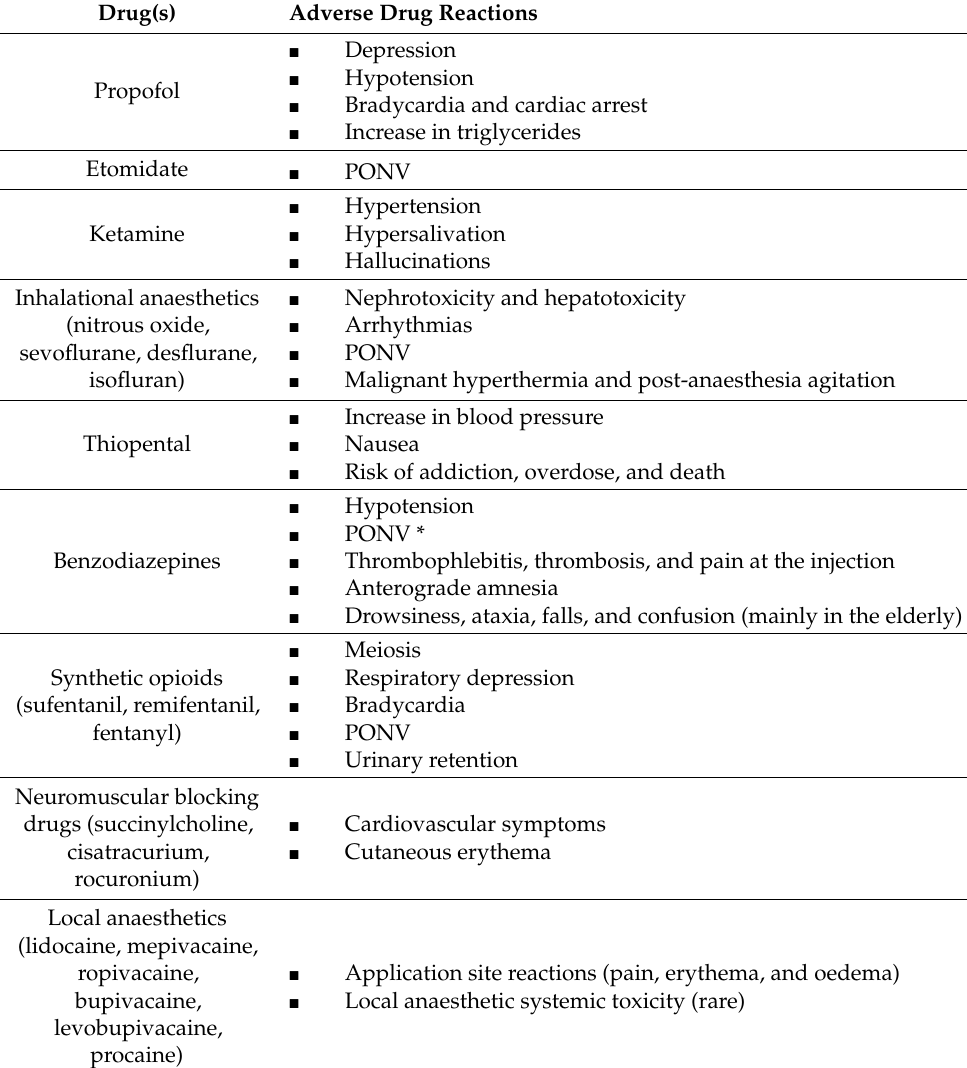
Table 1. Adverse drug reactions associated with drugs used in general and local